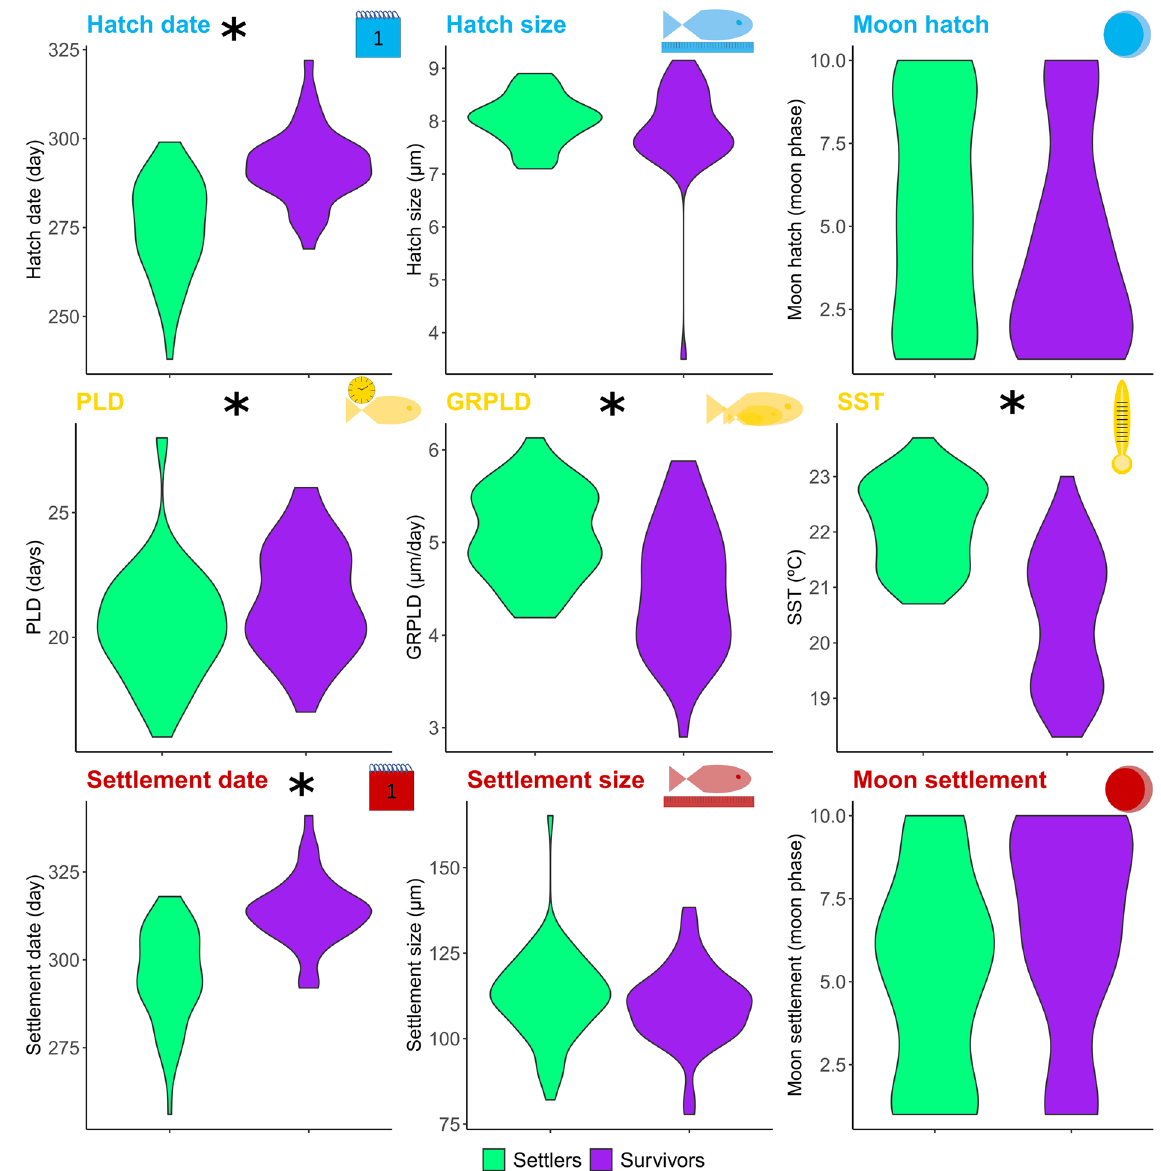
Figure 2. Biological and environmental signatures in early life stages in fish. Violin plots of the phenotypic and environmental values in settlers and survivors obtained from individual otolith readings during different early- life stages grouped by hatch, larval and settlement variables. Asterisks indicate significant differences between settlers and survivors according to the Permanova test, suggesting differential survival for these